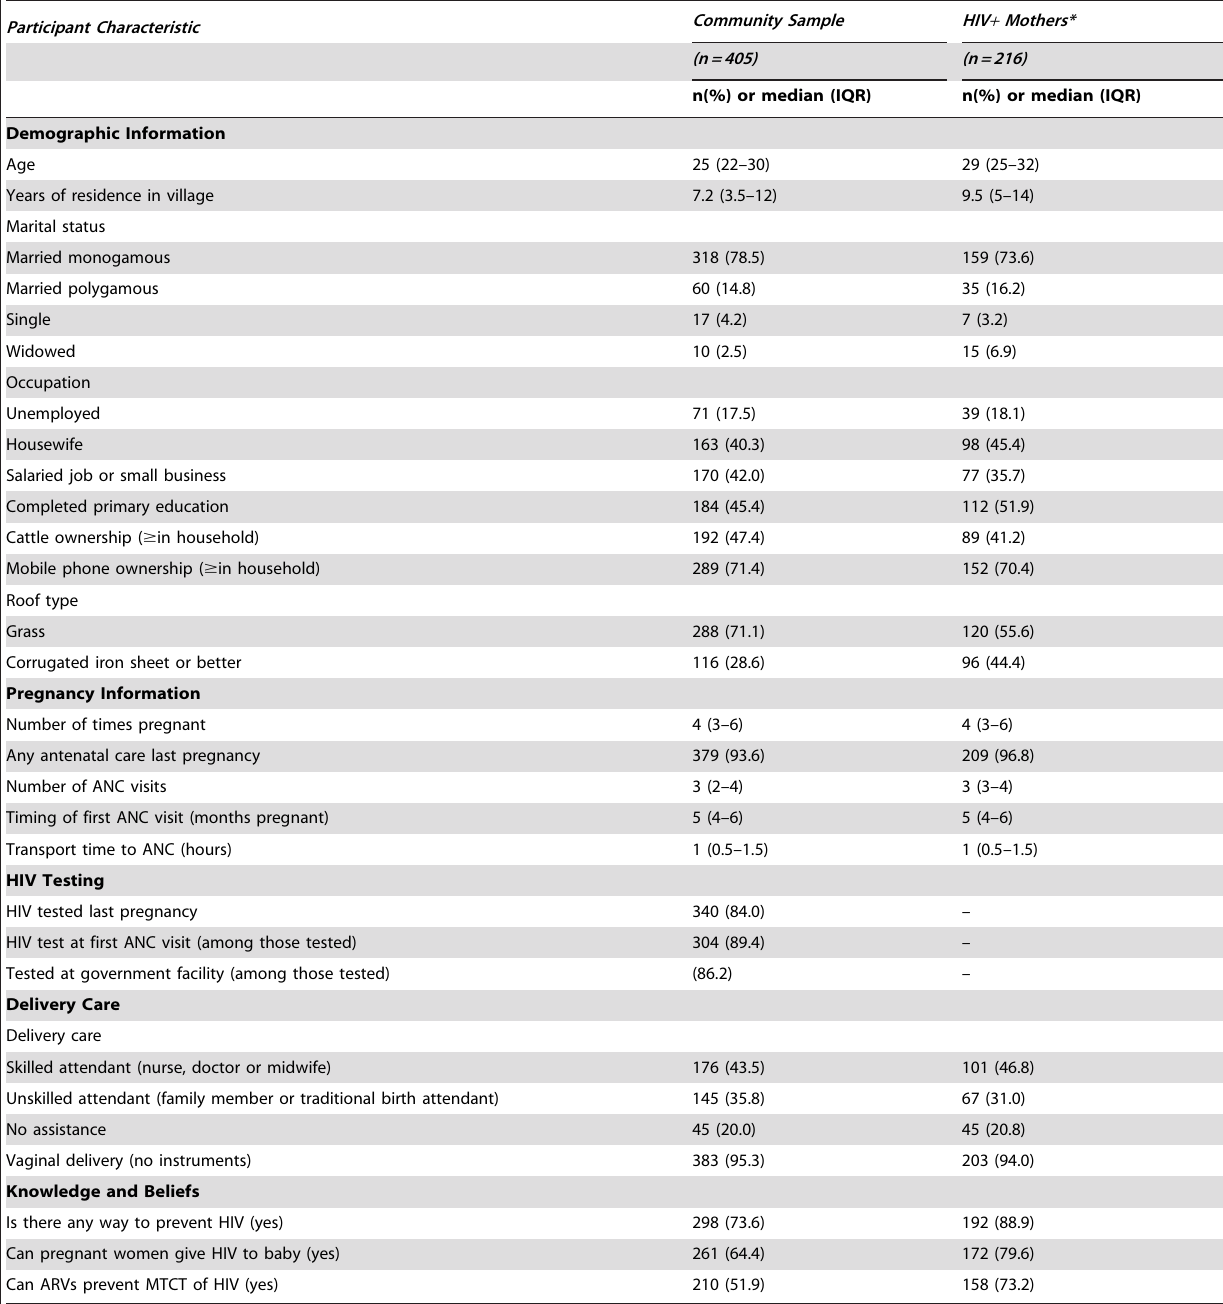
Table 1. Population and